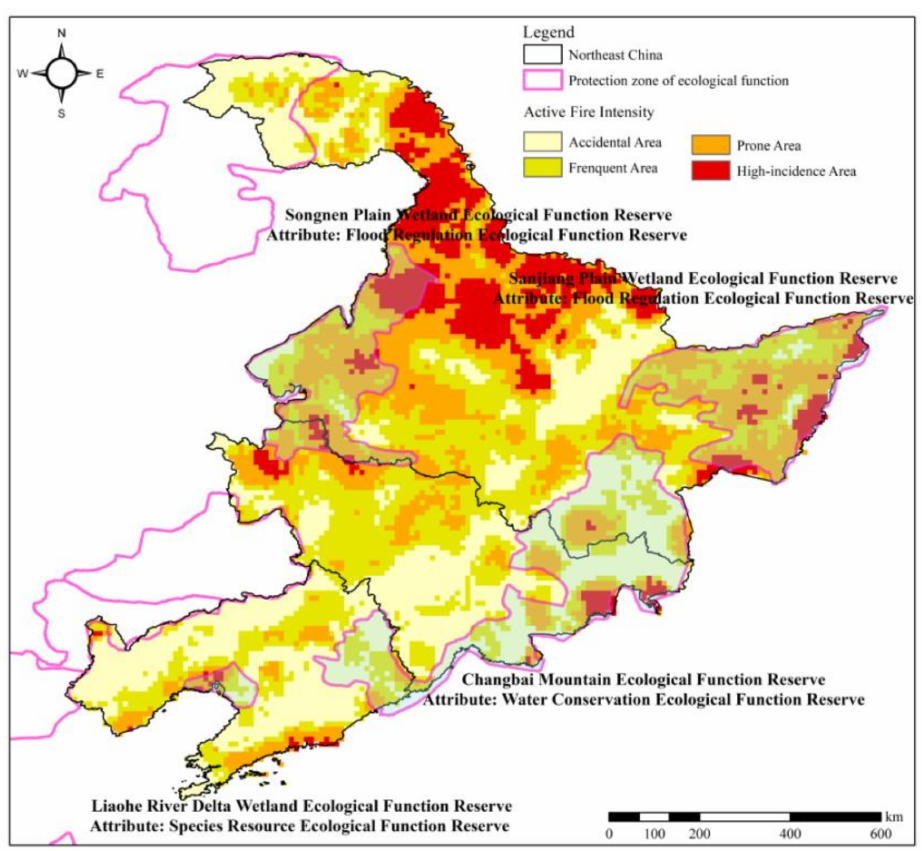
Figure 5. Classification map of fire-hazardous areas of VIIRS active fires in Northeast